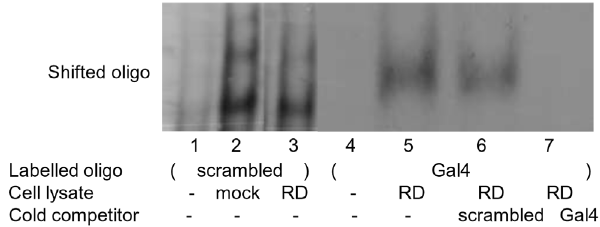
Figure 3. Electrophoretic mobility shift analysis of Gli3RD and DNA binding. Cell lysate from Gli3RD or mock-transfected HEK293 cells incubated with labelled scrambled sequence oligonucleotide is shown in line 3 and line 2, respectively. As a negative control, the labelled scrambled oligonucleotide was loaded alone, without a cell lysate, on line 1. Labelled Gal4 binding site (BS) oligonucleotides were used to confirm the presence of Gal4 DBD tagged Gli3RD. On line 4 the Gal4 BS oligonucleotide is loaded alone. The DNA-protein complex formed by the Gal4 BS oligonucleotide and Gal4 DBD tagged Gli3RD is indicated on line 5. The shifted complex was competed out by unlabelled Gal4 BS oligonucleotide (line 7). Scrambled sequence oligonucleotide did not compete out the complex (line 6).